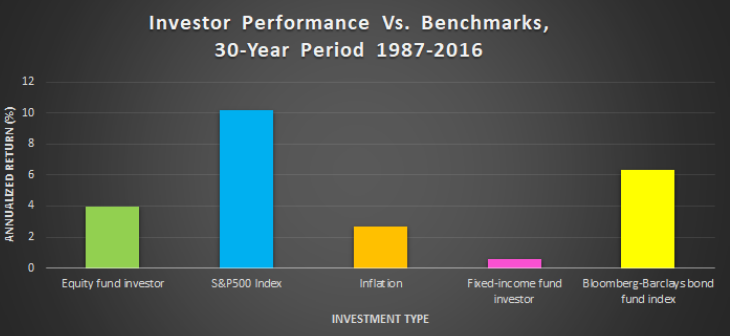
Figure 5. Individual investors consistently and deeply underperform buy-and-hold in index funds, for (a) stocks and (b) bonds, as reported in (Roberts 2017). Notice that this period included most of the big Black Swan events, which often send individual investors selling at just the wrong time. Fixed-income investors did not even tread water vs.